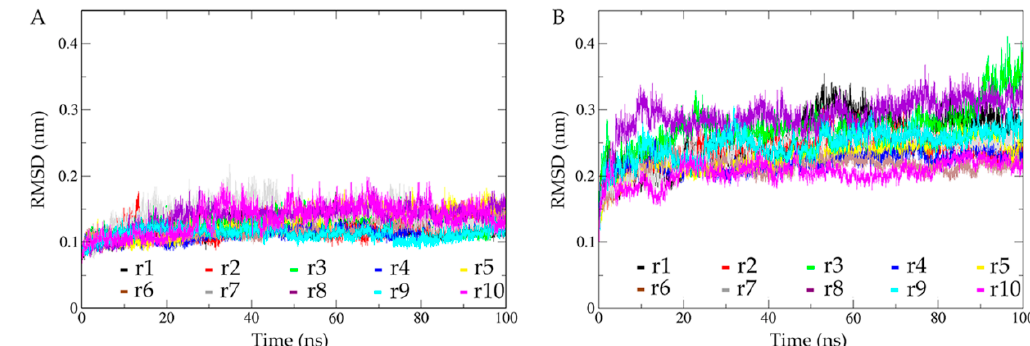
Figure 2. Time evolution of the C α root mean square deviation (RMSD) values of mSHMT and pSHMT with respect to their respective starting structures calculated from the 10 MD simulation replicas (r1-10). ( A ) mSHMT. ( B ) pSHMT.